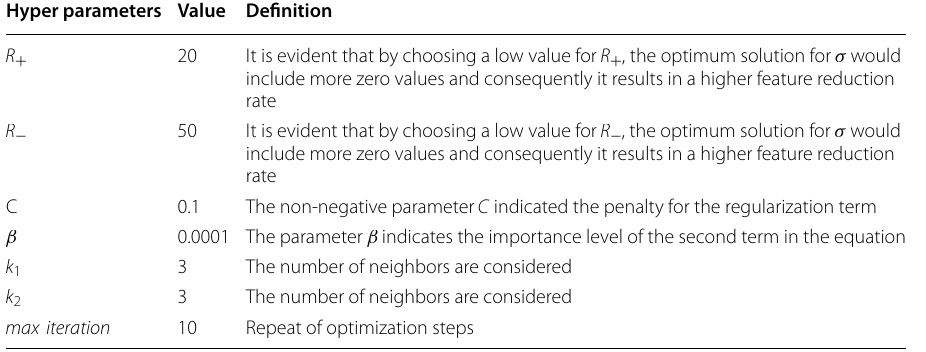
Table 4 The best values of the parameters obtained by the PSO evolutionary algorithm Hyper parameters Value